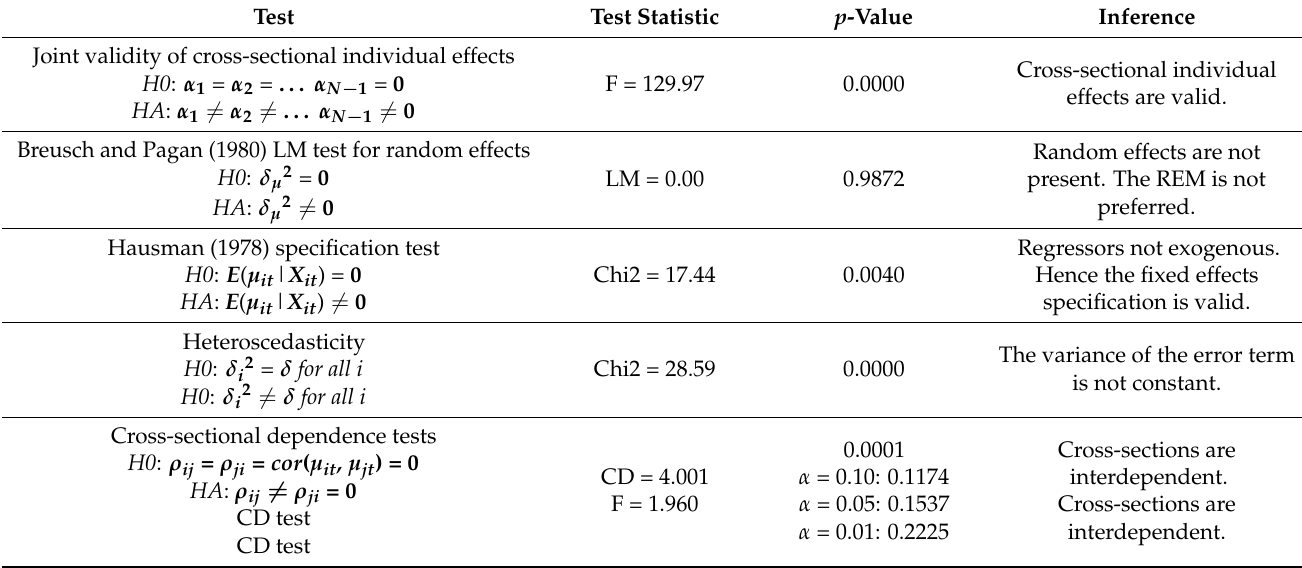
Table A2. Diagnostic tests with life insurance density employed as the dependent